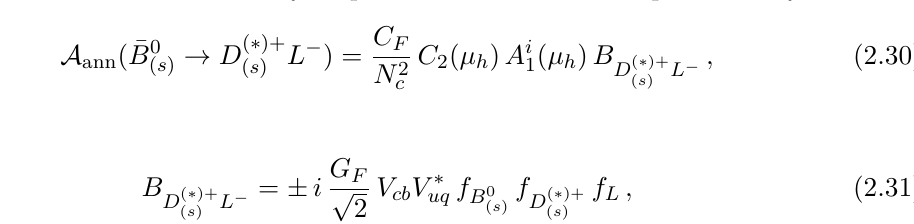
Figure 4 . Annihilation diagrams contributing to the class-I ¯ B 0 The other captions are the same as in figure